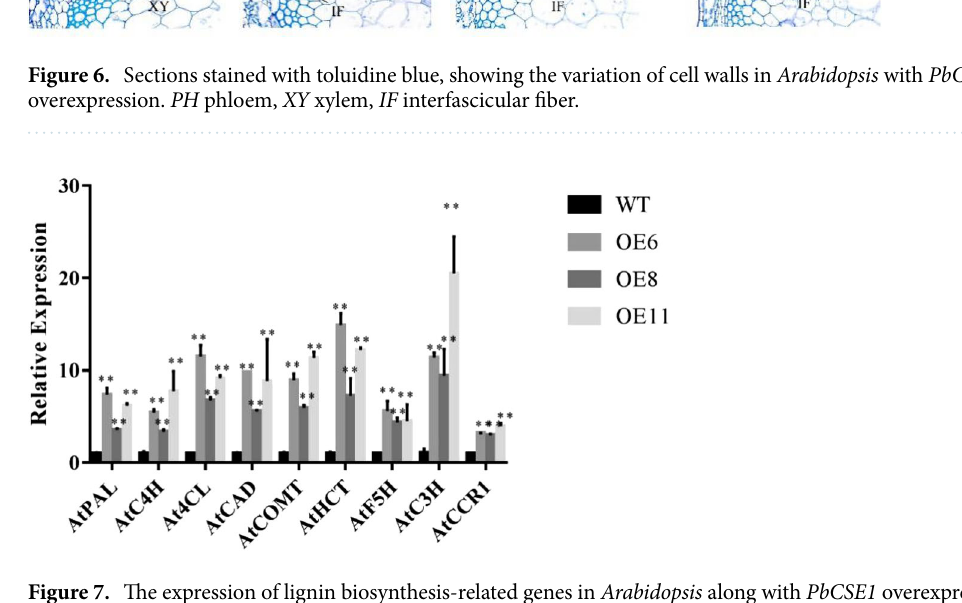
Figure 7. The expression of lignin biosynthesis-related genes in Arabidopsis along with PbCSE1 overexpression (** p < 0.01). The genes selected for expression analysis have been previously shown to be highly expressed in stems where lignified fibers and vessels are abundant 14